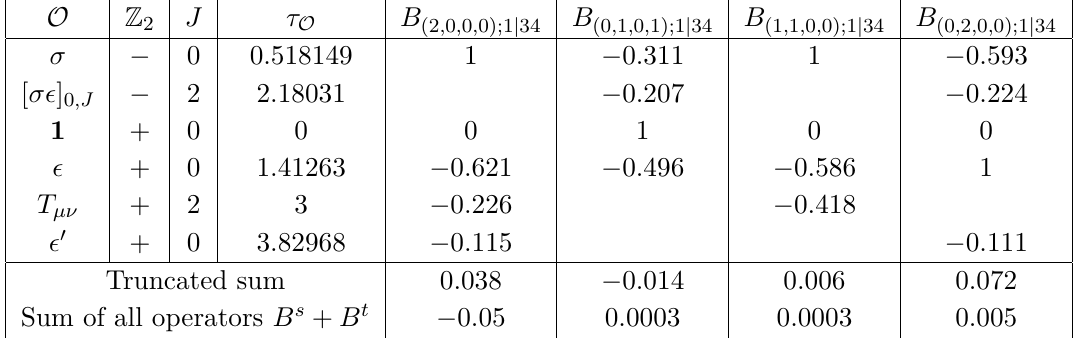
. The values are f O i O j O l O k O